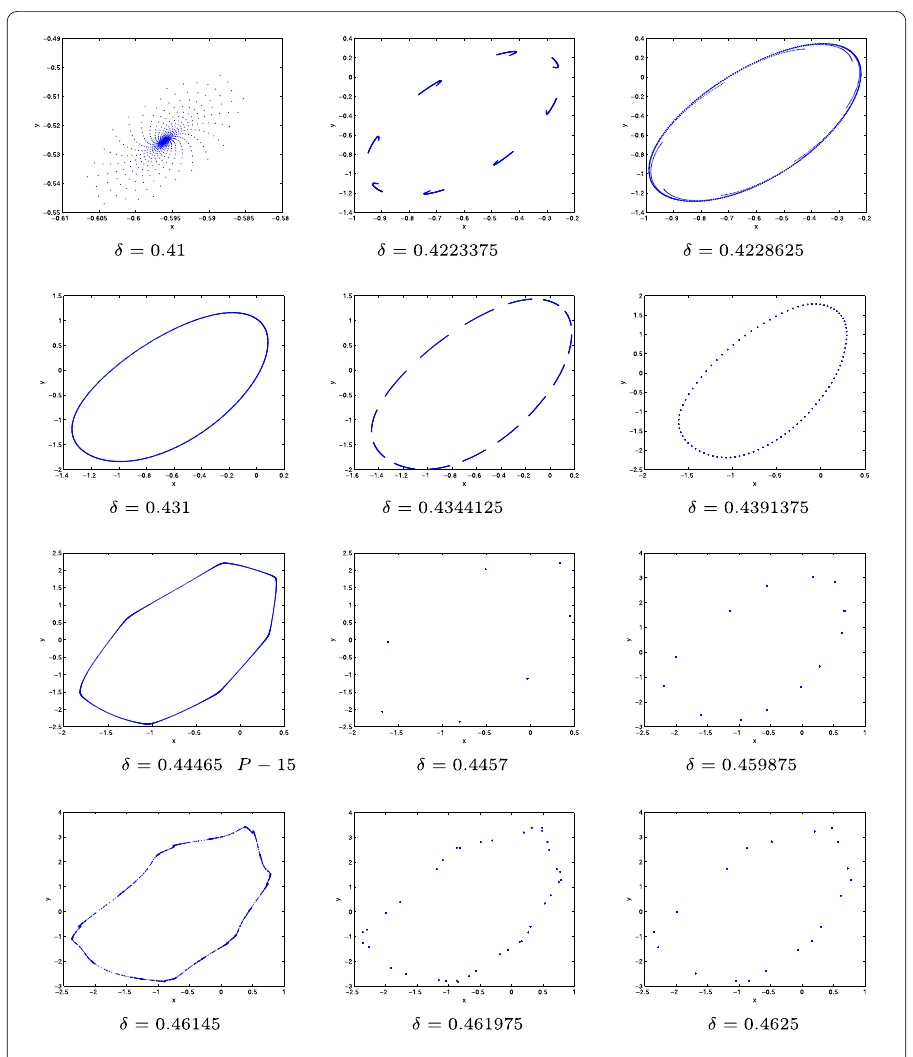
Figure 5 Phase portraits for various values of δ corresponding to Fig. 4